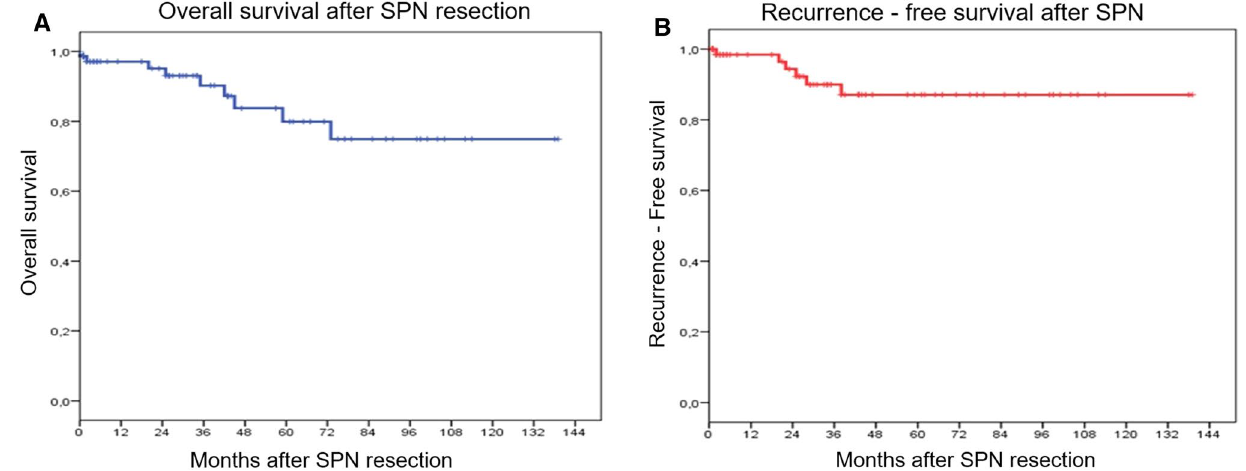
Fig. 2 Overall survival ( A ) and reccurence-free survival ( B ) of patients with solid pseudopapillary neoplasm (SPN) who underwent pancreas